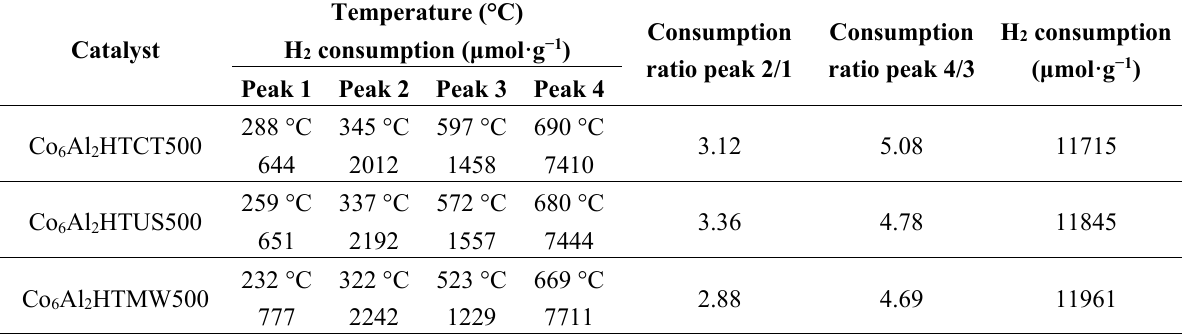
Table 2. Temperatures for H 2 consumptions by TPR experiments Co 6 Al 2 HT500 issued from different preparation methods.